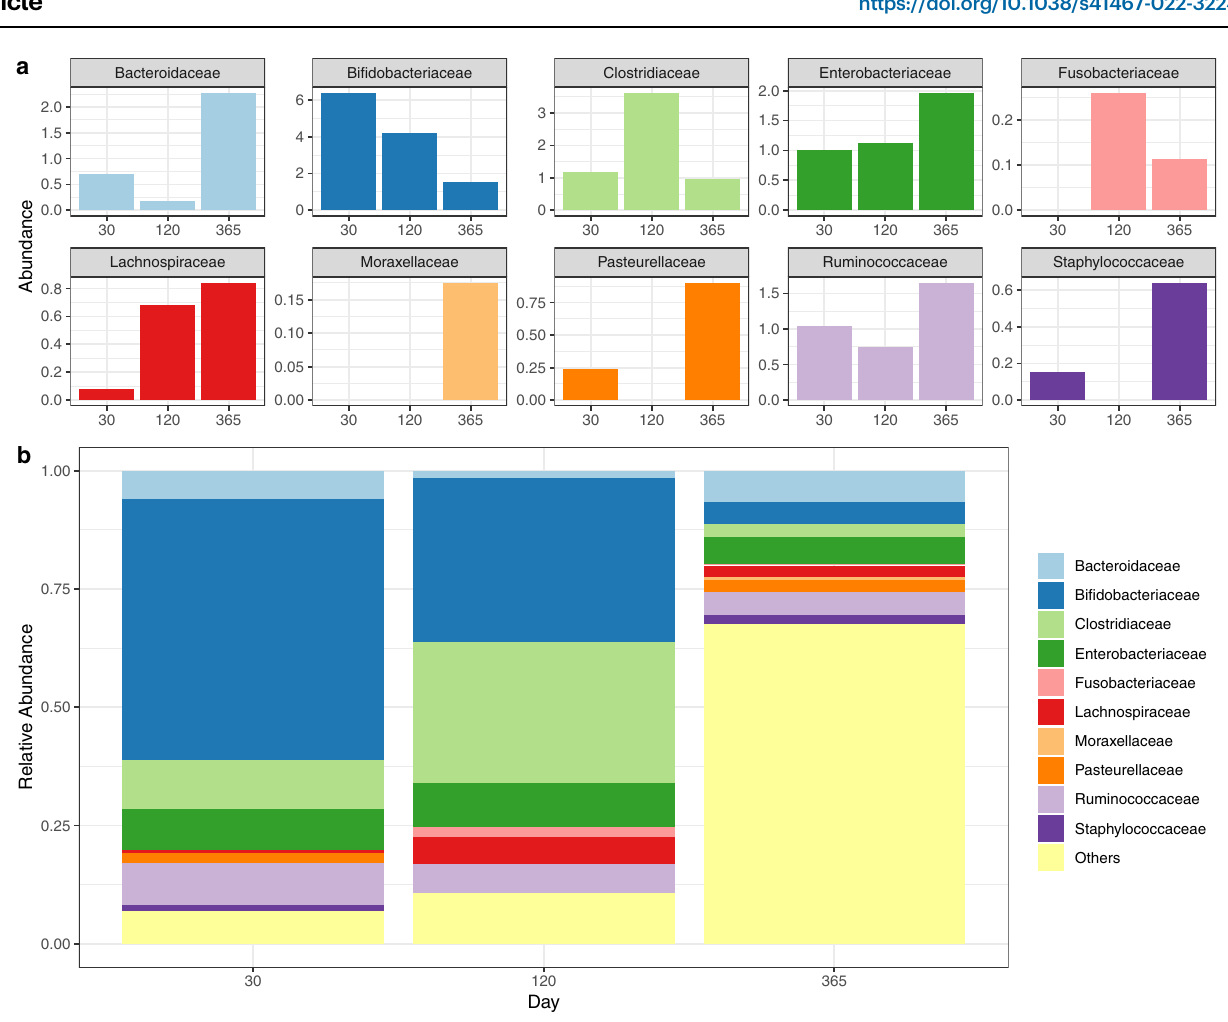
taxa up to 365 days were selected for the visualization purpose. Families with prevalence across samples <10% were not shown separately and grouped into “ Others ” . Different taxa were coded by different colors, as shown on the